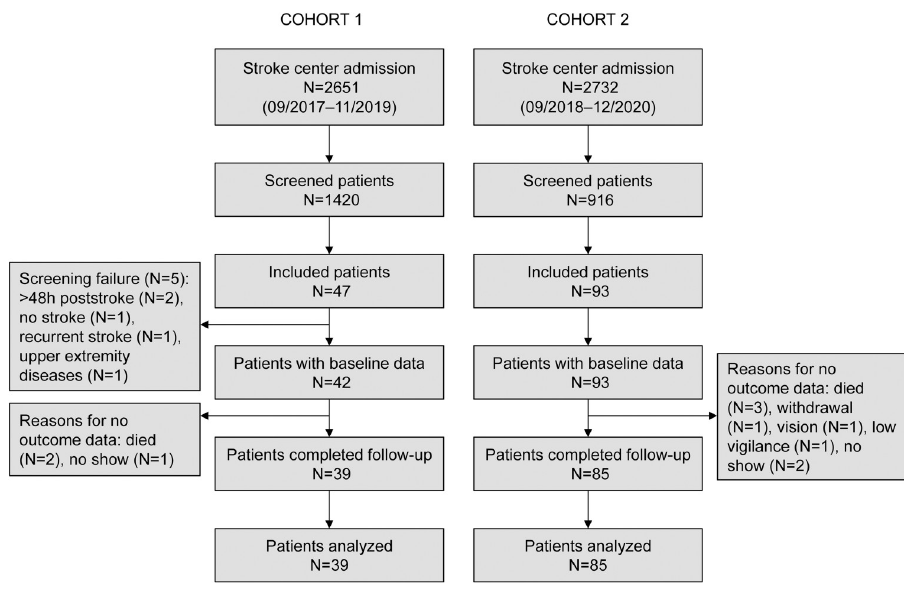
Fig 1. Flow chart for the validation